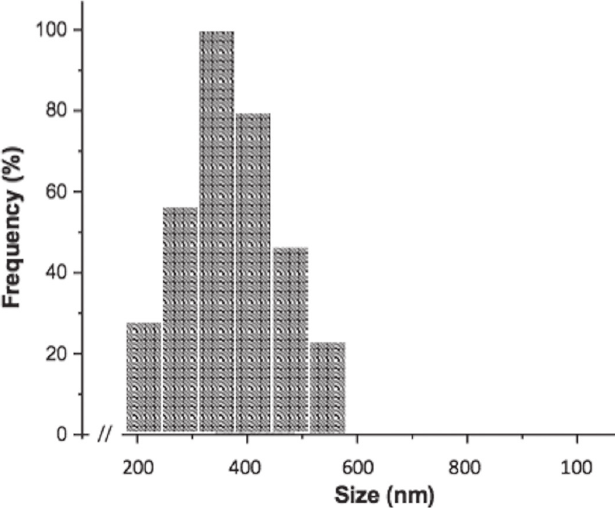
FIGURE 1 - Size distribution profile of BSA nanoparticles containing rutin.